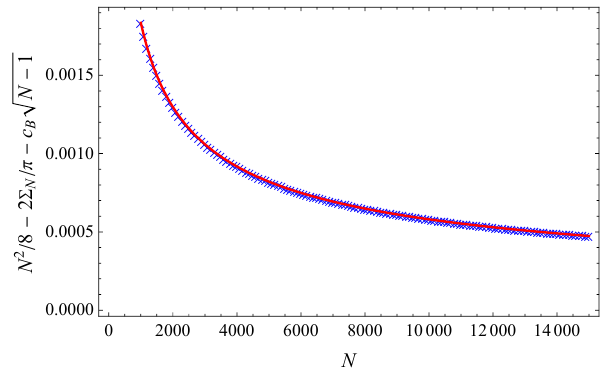
Figure 6 . Difference N 2 / 8 − 2Σ N /π − c B [1000 , 15000] in increments of 100 (blue crosses), compared to the curve 0 . 0580365 /